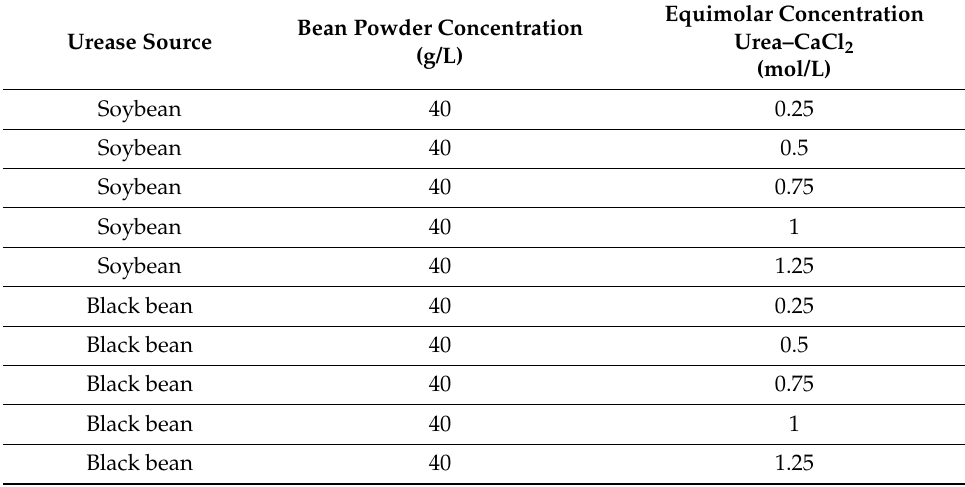
Table 1. Treatment Solution.